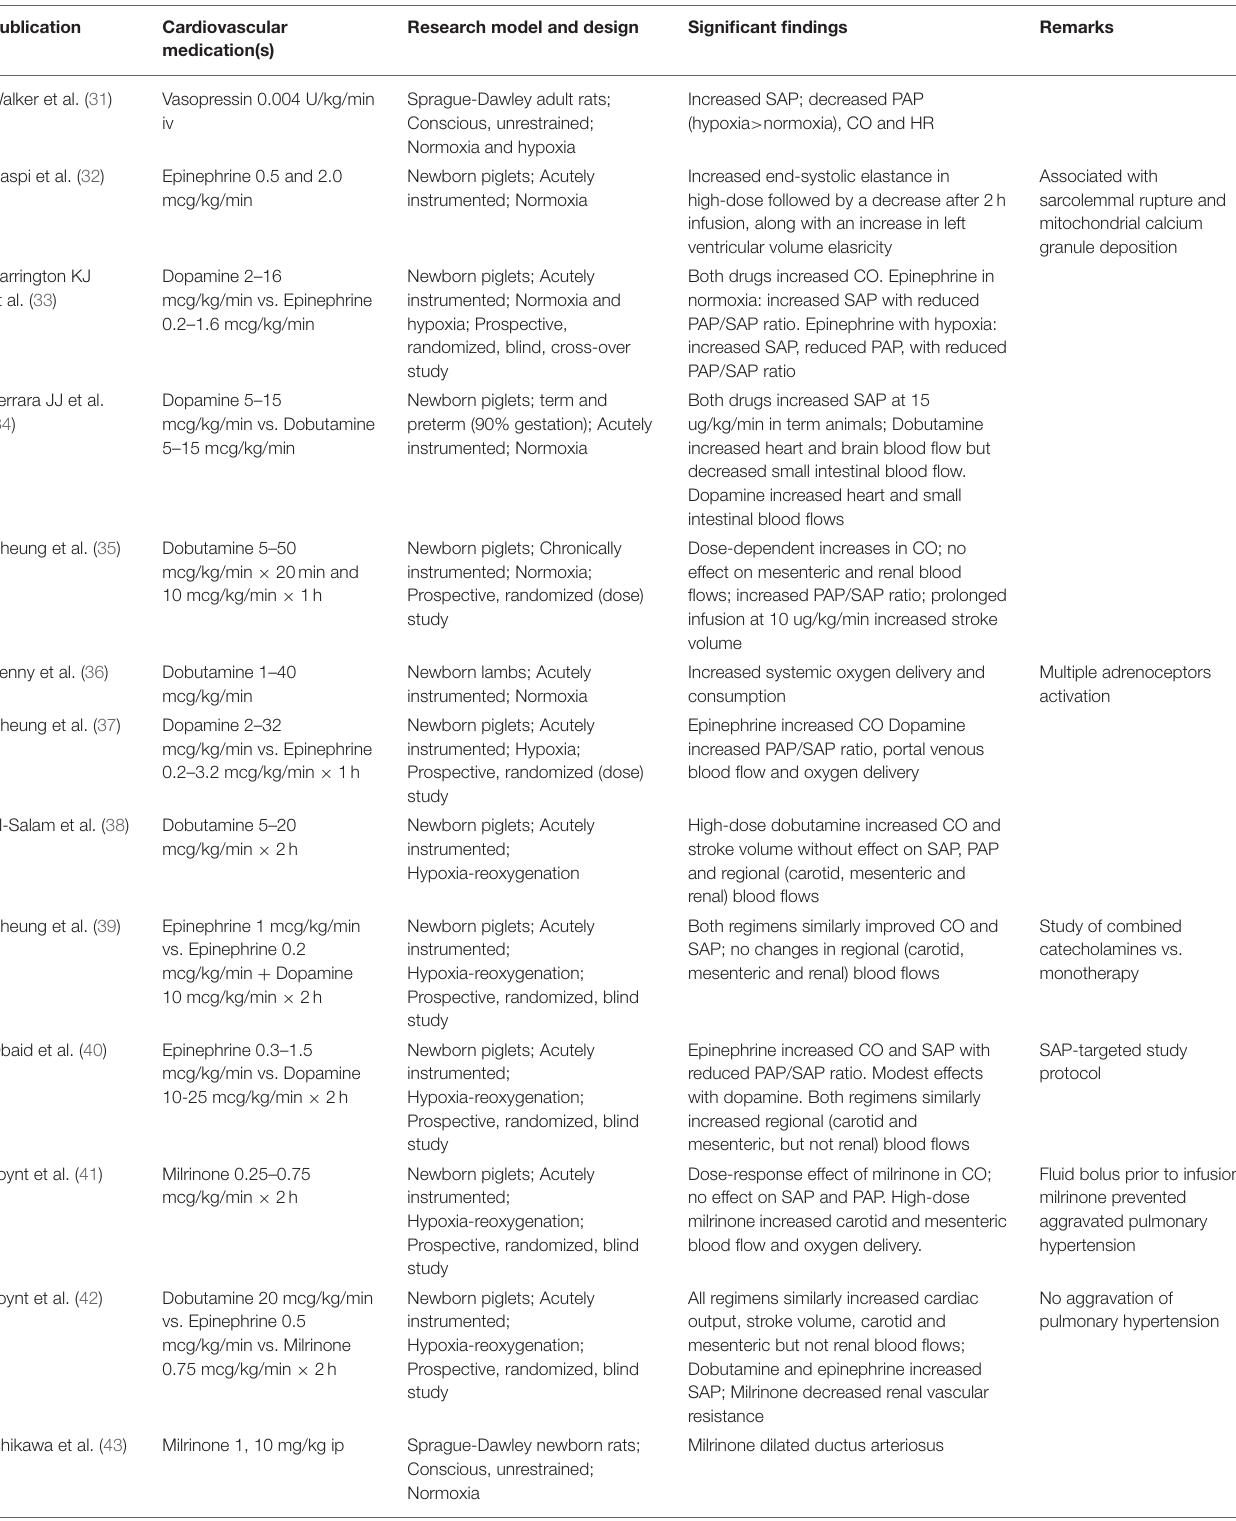
TABLE 2 | Relevant intact animal studies on the hemodynamic effects of cardiovascular medications in neonatal